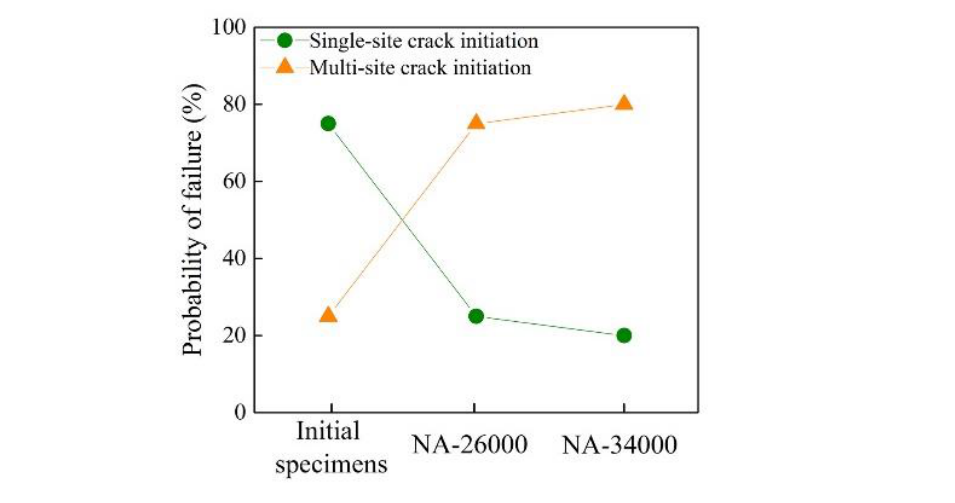
Figure 5. Probability of crack initiation modes for 25CrMo4 specimens after different natural-aging Figure 6. Microstructure characteristics of 25CrMo4 steel. ( a ) Microstructure image and ( b ) hardness durations. of ferrite and cementite-enriched area in the microstructure.